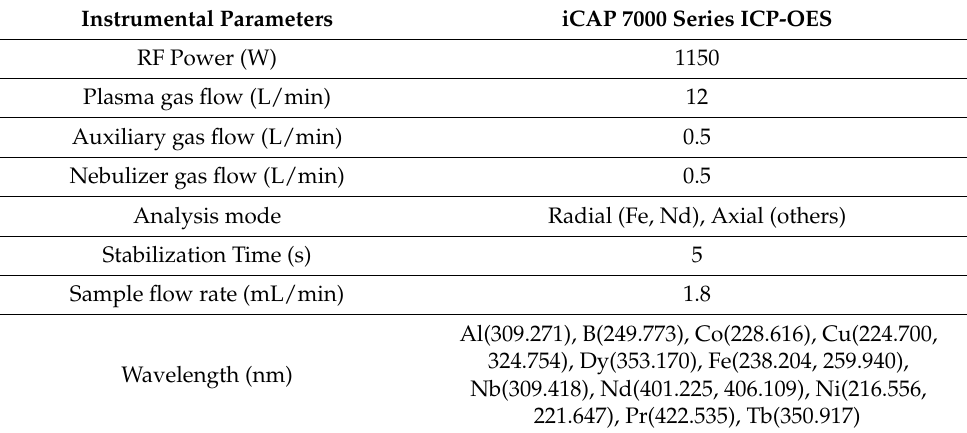
Table 2. ICP-OES operating